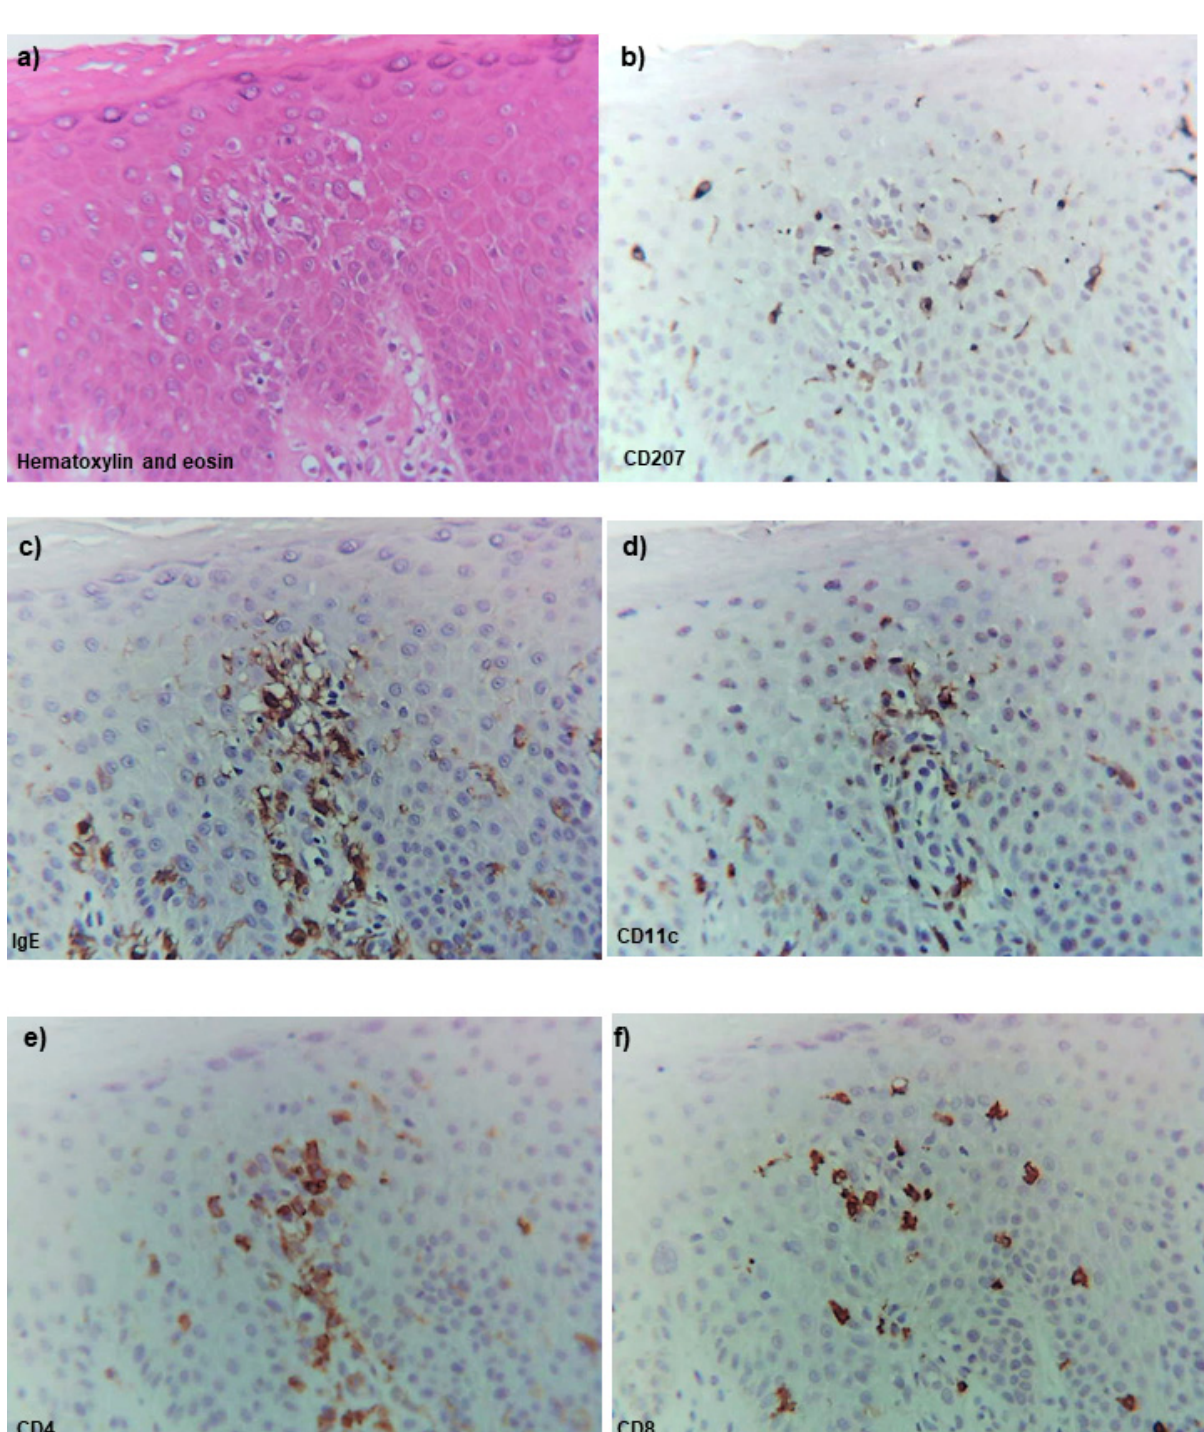
Figure 4. Routine and single-immunohistochemical staining for active lesions of chronic AD in a patient with IgE-allergic AD and HDM allergy. ( a ) An early lesion of spongiosis with the infiltration of mononuclear cells in the epidermis. ( b ) CD207+ cells were mainly seen in the peripheral area of the spongiosis. ( c ) Infiltrating IgE+ cells were observed to aggregate in the central area of the spongiosis. ( d ) Infiltrating CD11c+ cells that show similar localization as the infiltrating IgE+ cells were observed in the central area of the spongiosis. ( e ) Infiltrating CD4+ cells that showed similar localization as the infiltrating IgE+ cells and CD11c+ cells were observed in the central area of the spongiosis. ( f ) Infiltrating CD8+ cells were mainly seen in the peripheral area of the spongiosis. ( a ): Case 1; hematoxylin-eosin staining. ( b – f ): Case 1; single-immunohistochemical staining. Sets of ( a – f ) represent serial sections. Original magnification: 200×, ( a – f ).